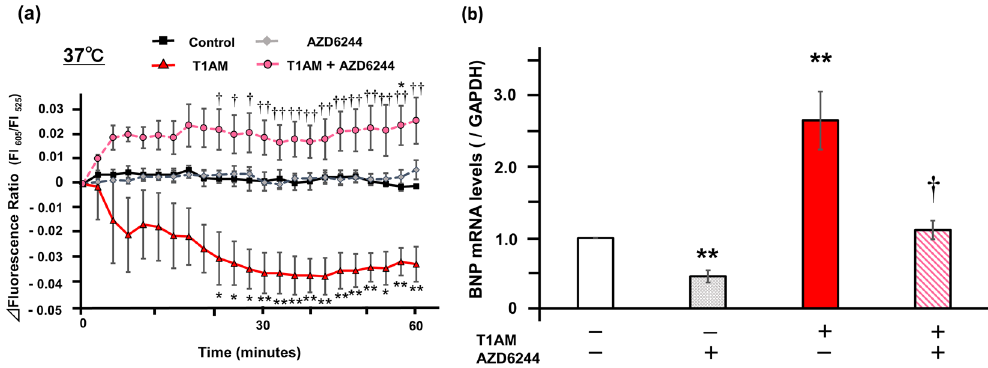
Figure 5. T1AM regulates thermoprobe-measured temperature and BNP expressions in NRCM through ERK signaling pathway. ( a ) The thermoprobe-measured temperature was indicated by the Δfluorescence ratio (605 nm/525 nm). The changes of the fluorescence ratio after treatment with or without T1AM (50 μM) stimulated with either AZD6244 (500 nM) or vehicle were recorded every 2 min for the first 15 min and every 3 min for the remaining 45 min at 37 °C (n = 3 each). * P < 0.05 and ** P < 0.01 versus control; † P < 0.05 and †† P < 0.01 versus T1AM at each time point. ( b ) The quantification of the BNP gene expression levels in NRCM after six hours of incubation with or without T1AM (50 μM) stimulated with either AZD6244 (500 nM) or vehicle were shown (n = 4 each). The qPCR data were normalized to GAPDH. The data are shown as the fold change normalized to the levels found in vehicle-treated cells (control). ** P < 0.01 versus control; † P < 0.05 versus